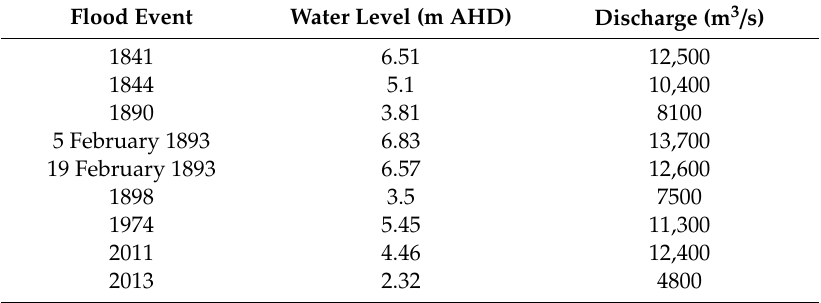
Table 1. Historic flood events at Brisbane City with their water level and discharge values [41].